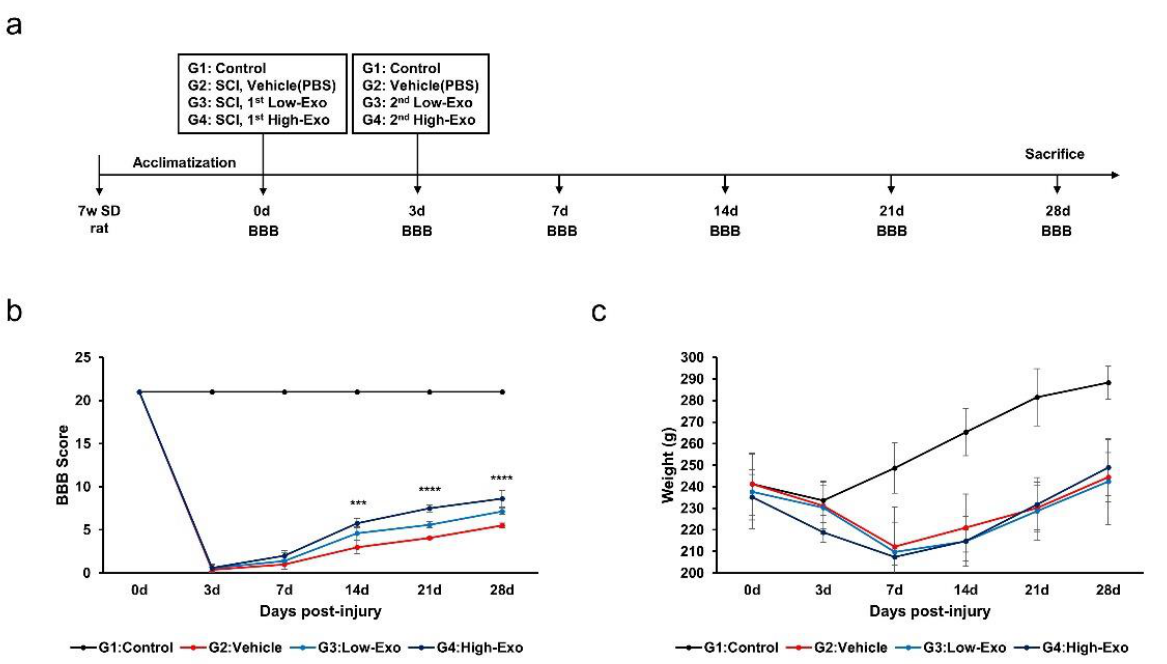
Figure 3. In vivo evaluation of hEpi AD–MSC exosomes for SCI treatment: ( a ) schematic representation of SCI rat model with exosome injection; ( b ) hindlimb locomotor function was measured using the BBB scoring method for 28 d. Score ranged from 0 to 21 depending on the function of hindlimb (*** p ≤ 0.001, **** p ≤ 0.0001 between the Vehicle and High-Exo group); ( c ) mean body weight in non-treated and SCI-induced rat model ( n = 6, per group). Table 2. The p -value for BBB scoring and body weight. BBB Scores p -Value Body Weight p -Value Vehicle vs.